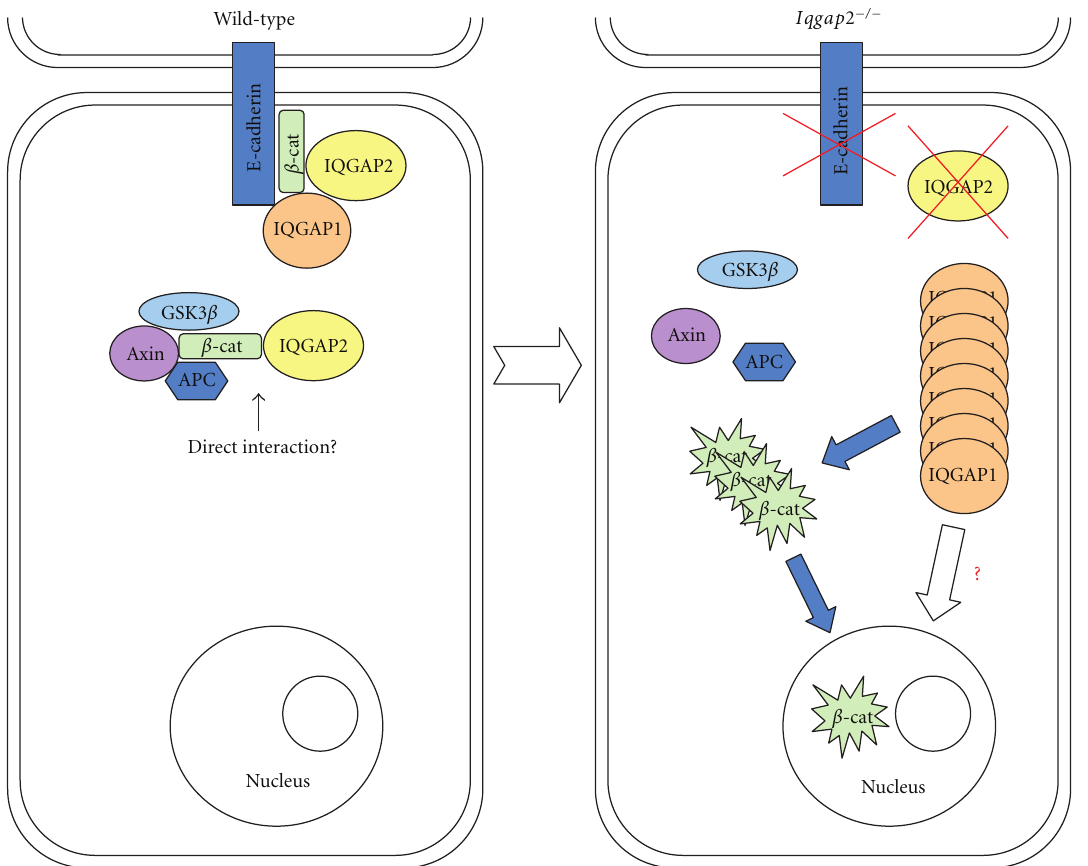
Figure 2: Schema summarizing the proposed hypothesis for IQGAP1 and IQGAP2 involvement in HCC development. In wild-type hepatocytes, IQGAP2 exists in two pools-bound to β -catenin and anchored at the submembrane region along with E-cadherin and IQGAP1, and as a part of the β -catenin destruction complex consisting of GSK3 β kinase, Axin and Adenomatous polyposis coli (APC). The β -catenin destruction complex prevents β -catenin activation and translocation to the nucleus. In Iqgap2 − / − hepatocytes, E-cadherin disappears from the membrane, while β -catenin escapes the destruction complex, accumulates in the cytoplasm, and enters the nucleus, where it initiates transcription of various target genes. Simultaneously, IQGAP1, released from the submembrane region, is upregulated and perhaps acts in the similar to active β -catenin manner. Overexpressed IQGAP1 may also stimulate activity of destabilized β